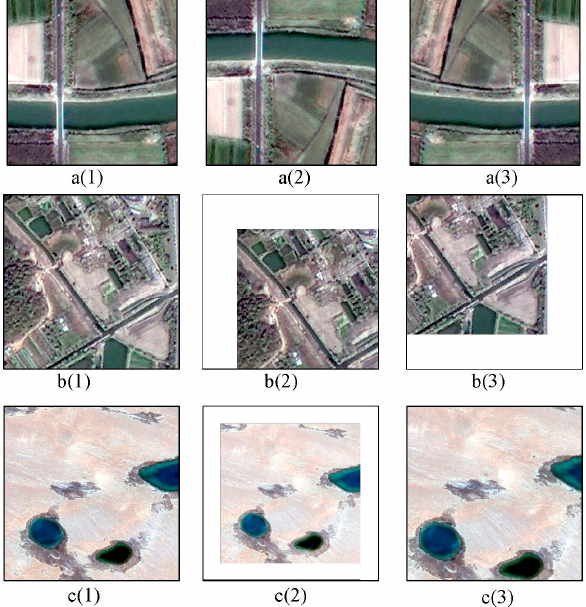
Figure 5. The structure of the multi-scale water extraction convolutional neural network (MWEN).